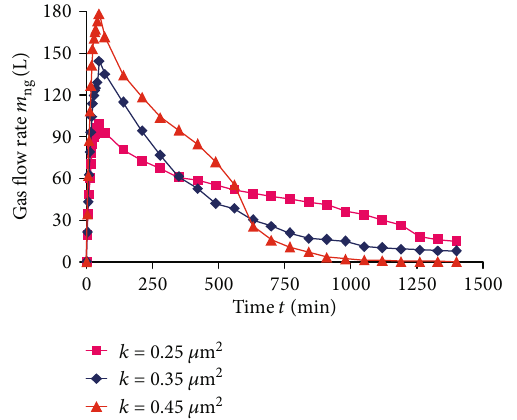
Figure 7: The e ff ect of intrinsic permeability on o ff shore natural gas fl ow rate in 3-D marine sediments under depressurization.